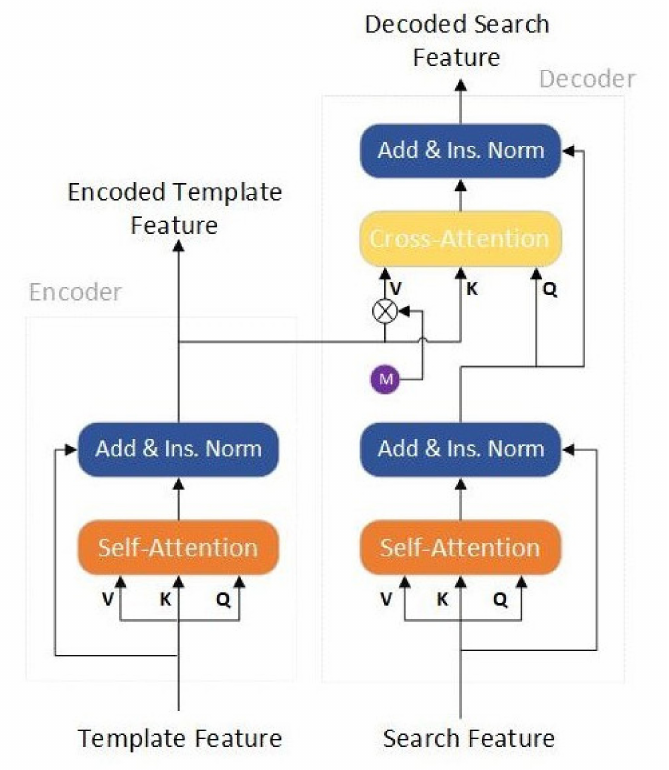
Figure 3. Simplified transformer architecture for Siamese-based tracking